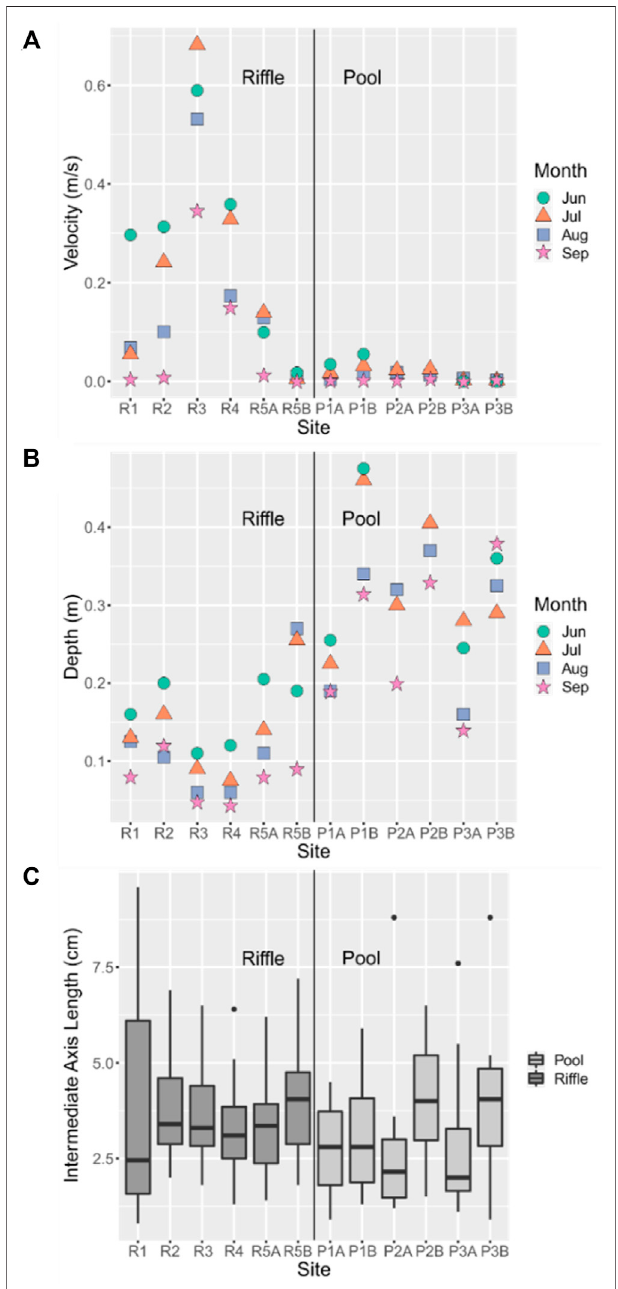
FIGURE 5 | Two-point average (A) velocity and (B) depth at each site in June, July, August, and September. Variability of (C) intermediate axis length of the 20 stones collected at each site in June. Lines extending from each box indicatetherange;topandbottomofboxesindicatetheupperandlower quartiles, respectively; horizontal lines crossing each box indicate the median; and single points indicate potential outliers. Sites are ordered downstream (left) to upstream (right) for each of pools and rif fl